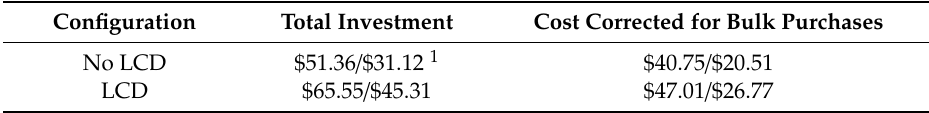
Table 5. The cost of the scale varies based on configuration and initial investment. Using a wall outlet for power (as opposed to a computer) costs an extra